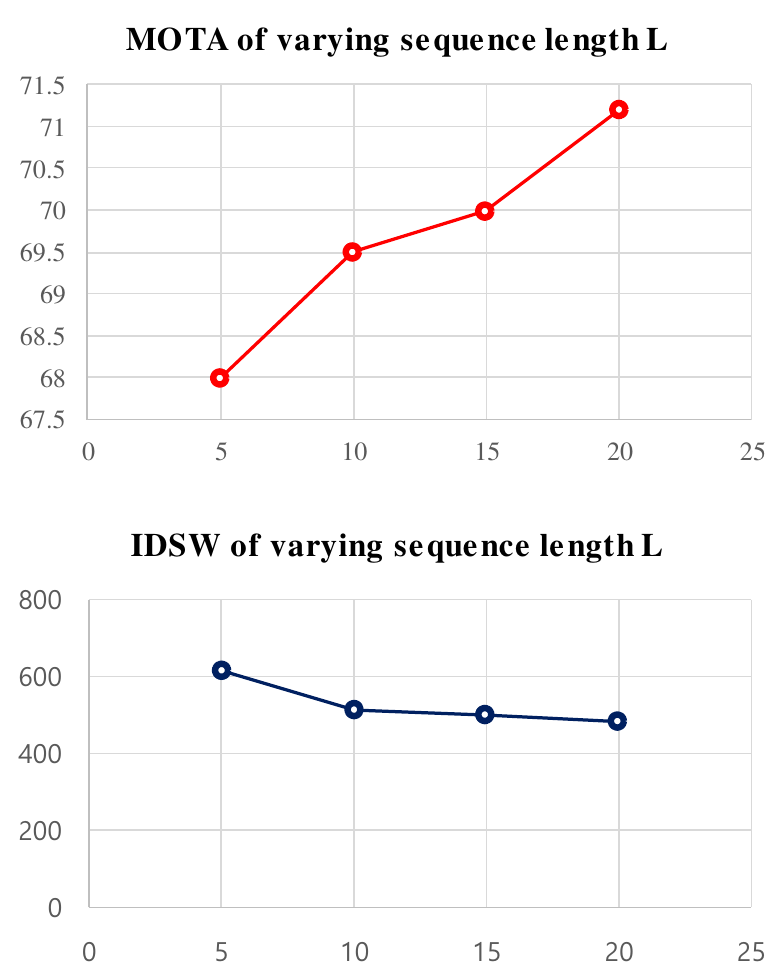
Figure 3. The effectiveness of our appearance model on the MOT17 training dataset for different lengths L and K